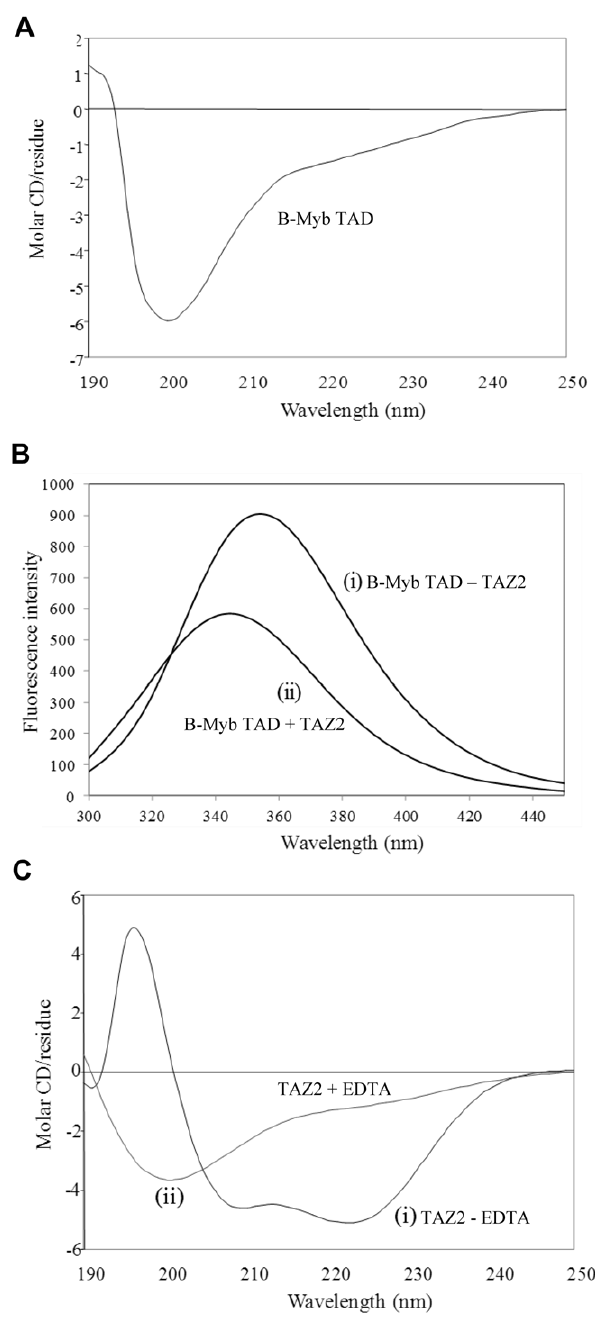
Figure 2. Far UV circular dichroism analysis of the B-Myb TAD and p300 TAZ2 domain. Panels A illustrates a typical far UV circular dichroism (CD) spectra obtained for the B-Myb TAD. Panel B shows representative intrinsic tryptophan fluorescence emission spectra obtained for the B-Myb TAD in the absence (i) and presence (ii) of an approximately three-fold molar excess of p300 TAZ2. In panel C far UV CD spectra of TAZ2 are shown in the absence (i) and presence (ii) of a molar excess of EDTA over Zn 2 +